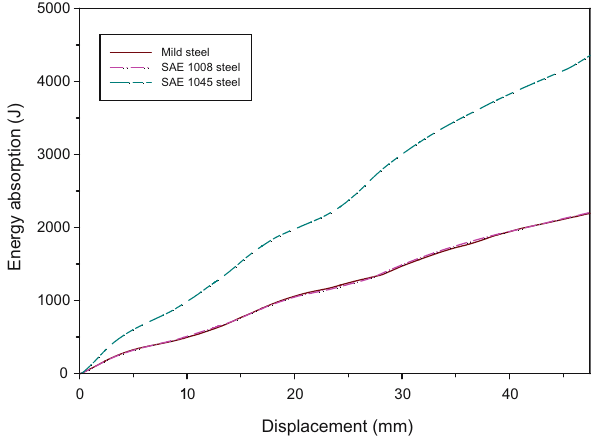
Figure 18: Energy absorption generated during axial loading with three steel materials.